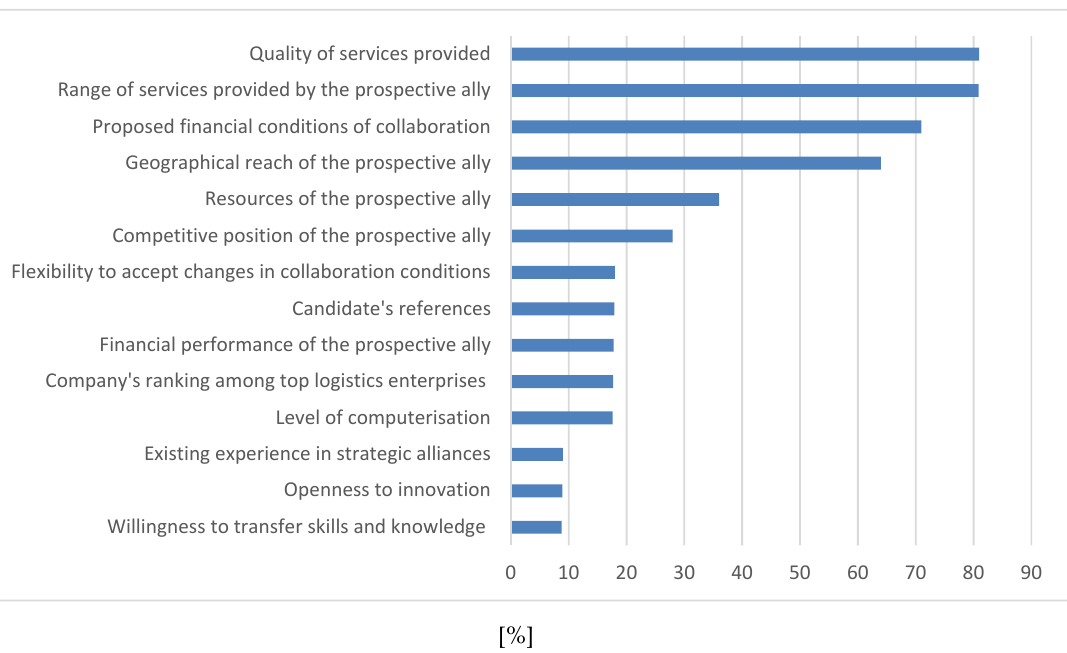
Figure 8. Selection criteria for a partner in a strategic alliance. (Source: Own study).